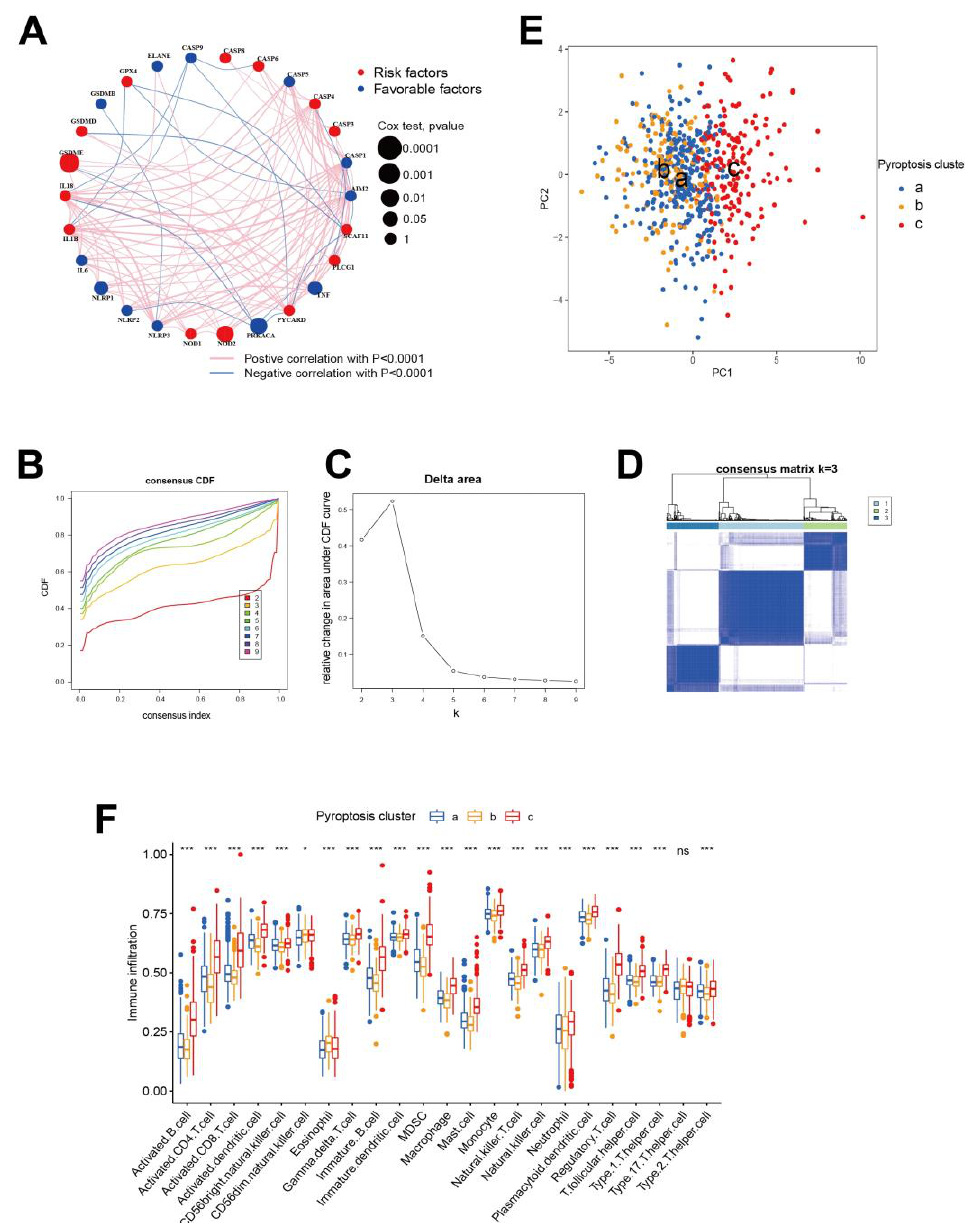
Figure 2. Identification of potential immune subtypes of HCC based on pyroptosis genes. ( A ) The correlation network of the pyroptosis-related genes (red line: positive correlation; blue line: negative correlation. The size ( p value from 0.001 to 1) of the dot reflects the strength of the relationship between each gene and prognosis). The colors of dots represent protective (blue) and risk roles (red), ( B ) cumulative distribution function (CDF) curve, ( C ) cumulative delta area under CDF for optimum decision of k value, and ( D ) sample clustering heat map (k = 3). ( E ) PCA plots of clusters A (blue), B (yellow), and A (red). ( F ) Immune landscape of immune infiltration of three pattern clusters from ssGSEA. ns: not significant, * p < 0.05, *** p <